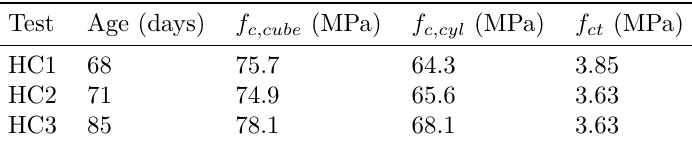
Table 1. Sample characteristics of material properties for concrete.